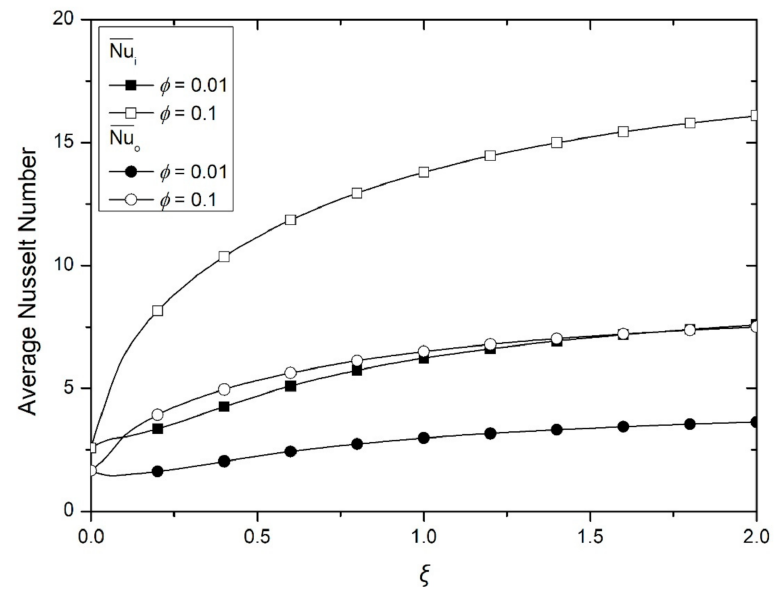
Figure 5. Effect of φ and ξ values on the average Nusselt number of the inner and outer cylinder for Gr = 10 3 .